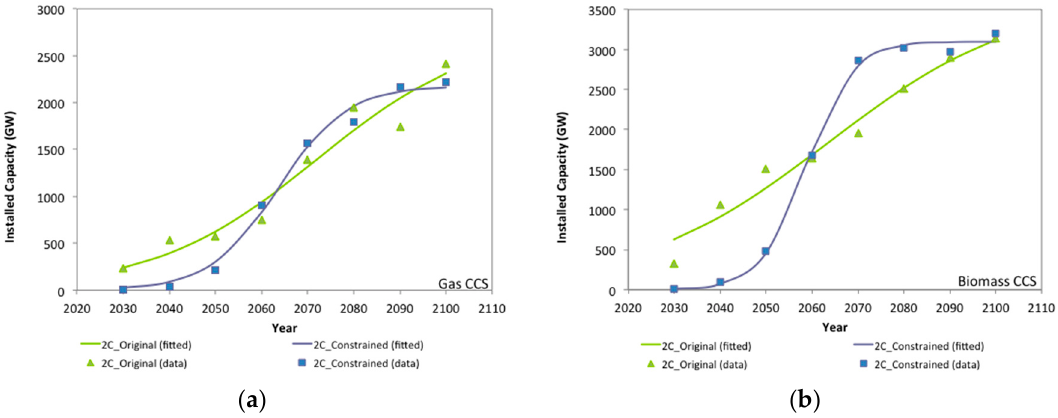
Figure 5. Comparison of the deployment curves for the original and constrained scenarios showing the fit with a logistic growth curve for ( a ) Gas CCS and ( b ) Biomass CCS.